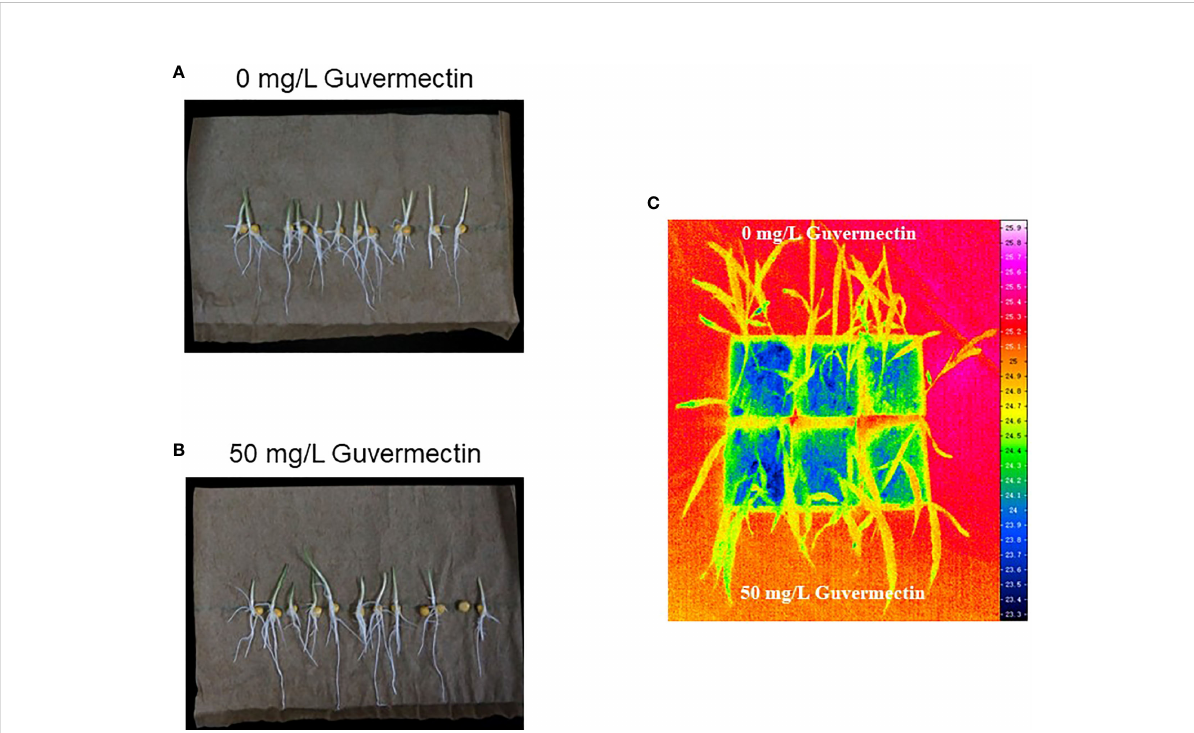
FIGURE 2 The effect of guvermectin treatment on the tolerance of high temperature at maize seedlings stage. (A) Maize seedlings growth after 0 mg/L guvermectin treatment in paper roll culture system under high temperature). (B) Maize seedlings growth after 50 mg/L guvermectin treatment in paper roll culture system under high temperature. (C) The surface temperature of leaves measured by varioCAM HD infrared camera. The experiments were conducted with three biologically independent replicates experiments, per N>12 seedlings per